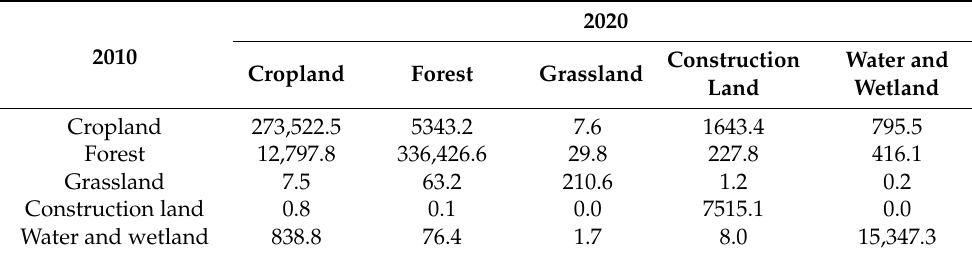
Table A4. The transfer matrix of land-use changes in the Mekong River Basin from 2010 to 2020 (km 2 ).